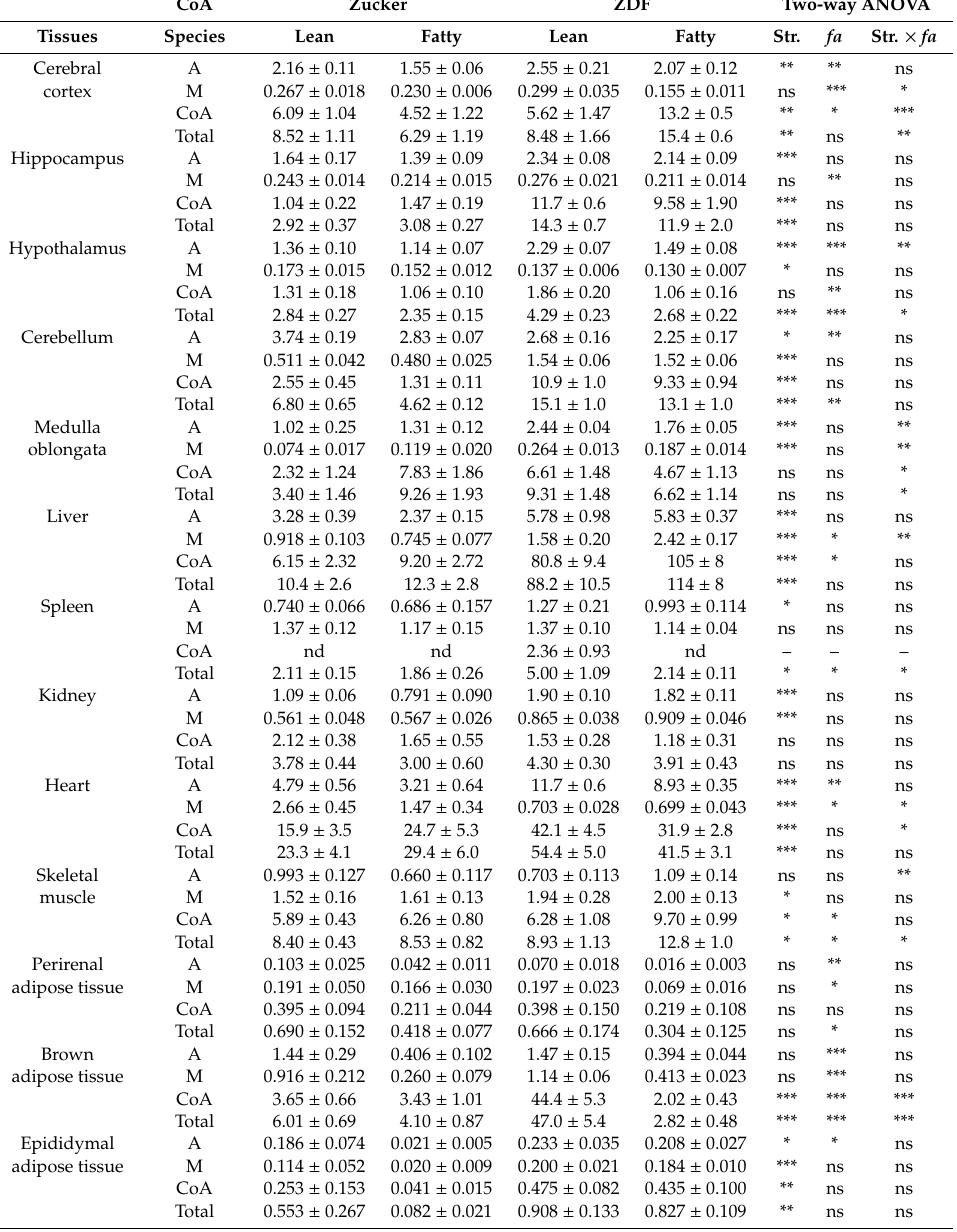
Table 3. CoA pools in rat